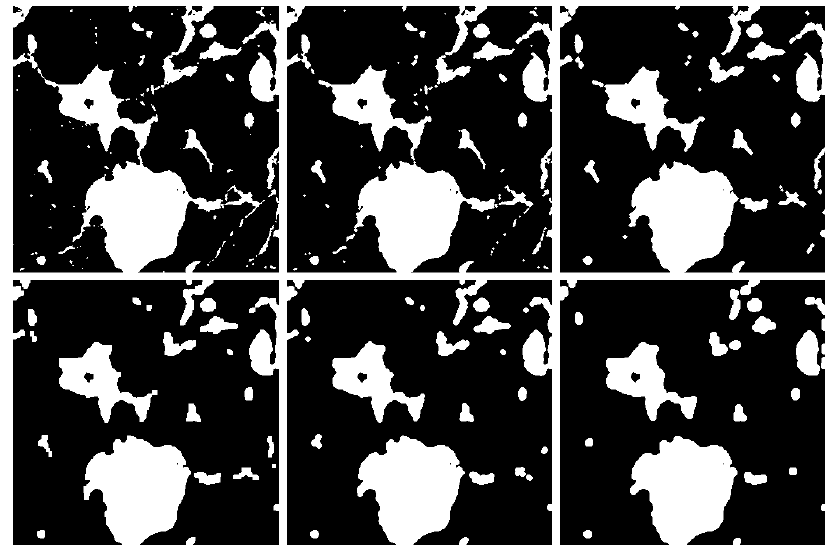
Figure 3. An example of morphological opening operation applied with structural units of different sizes for images of samples from the arable soil horizon. Voids are white and solid phase is black. Each image shows only the pores that are larger than the structural unit size used for the morphological opening.